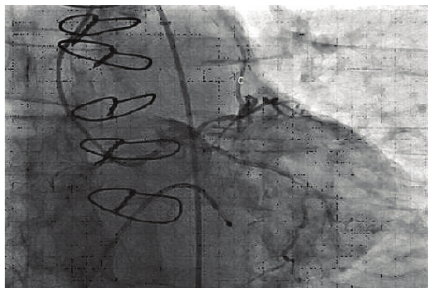
Figure 7: Left anterior oblique projection showing left coronary circulation with severe disease.